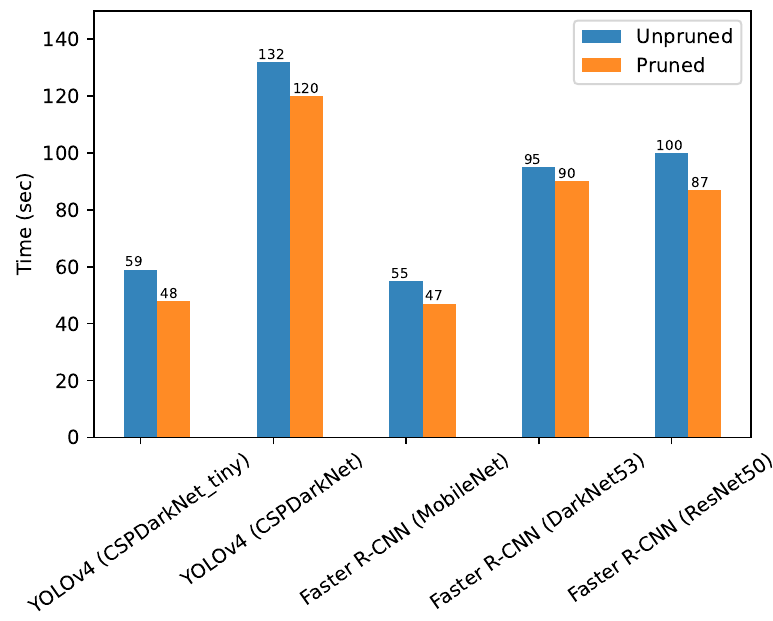
Figure 9. Training time per epoch for each implemented computer vision object detection model for plastic-bag contamination